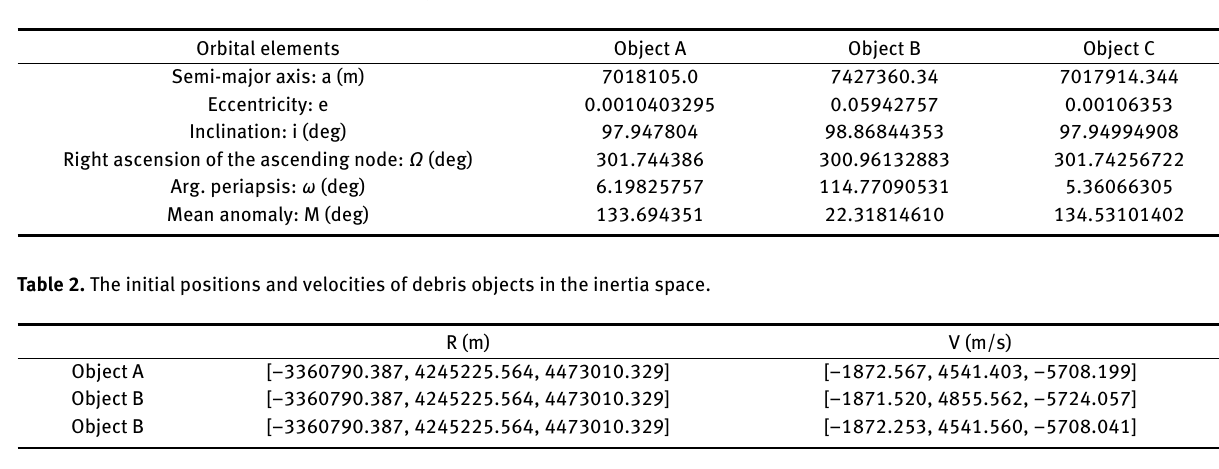
Figure 5 indicates the relative position of object C rel- y axis, i.e. the motion direction of the debris object. The ative to object A in the coordinate frame A-xyz. Figure 6 projection of the trajectory of C relative to A in xz plane shows the relative distance between these two objects A looks like an oblate ellipsoid. The maximum evolution of C and C. The integral time is also 86400s. From Figure 5(a) relative to A is in the y axis, which is 26.856 after 86400s, and 5(b), one can see that the major evolution is along the which is quite small than the evolution of Brelative to A.